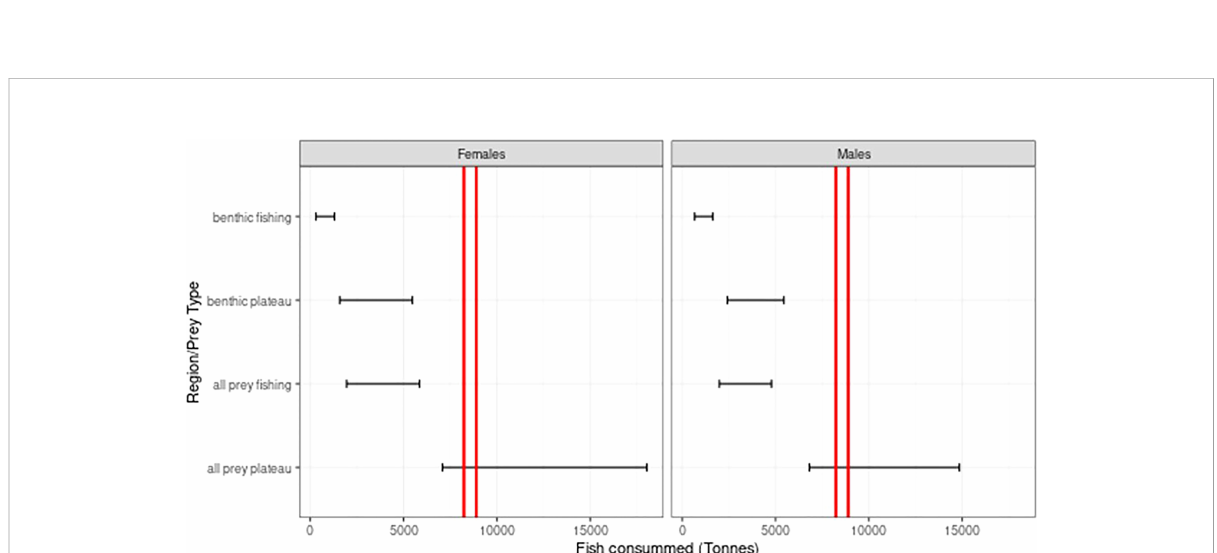
FIGURE 7 Estimates of fi sh (high energy content prey) consumption (tons) by southern elephant seals on the Kerguelen Plateau during their post-molt time at sea. Consumption estimates are separated regionally and by foraging the habitat identi fi ed from the seals dive behaviour (all benthos and water column plus benthos): Benthic prey within the fi shing grounds (Peron et al., 2016) (Benthic Fishing), benthic prey for the entire Plateau (Benthic Plateau), All prey types (benthic and epi-pelagic) within the fi shing grounds (All Prey Fishing) and All prey types for the entire Plateau (All Prey Plateau) Estimates are reported for adult females and three age classes of sub-adult males combined. Seal consumptions are presented as the maximum and minimum estimates for that sex/age class based on bootstrap analysis incorporating individual tracks, body size and a range of diet mixes (25% high energy content prey:75% low energy content prey, 50% high energy content prey:50% low energy content prey and 75% high energy content prey:25% low energy content prey) which are presented in more detail in Supplementary Materials 4, 5). The vertical red lines represent the upper and lower 95% CI of reported total catch rates (ice fi sh, tooth fi sh and IUU) on the plateau (8561 ± 334) tons) based on 17 years of catch data from 2004 to 2021 for CCAMLR Areas 85.2.1 and 85.2.2 (CCAMLR Secretariat, 2022b; CCAMLR Secretariat,